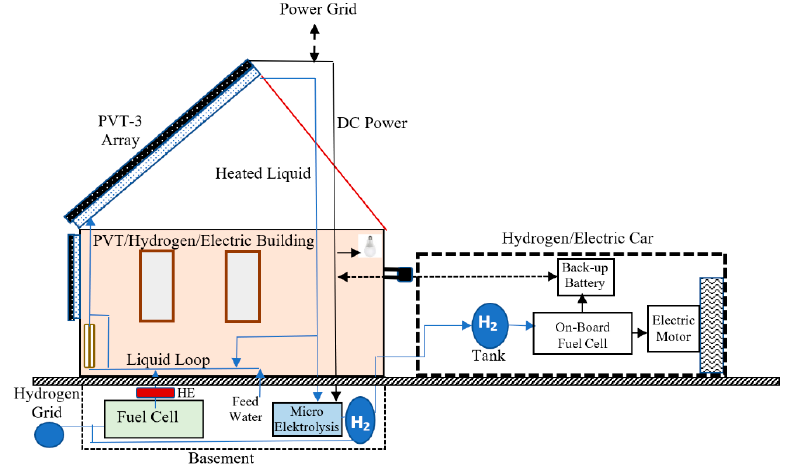
Figure 13. Schematic for Hydrogen Building to Hydrogen Car Interaction.